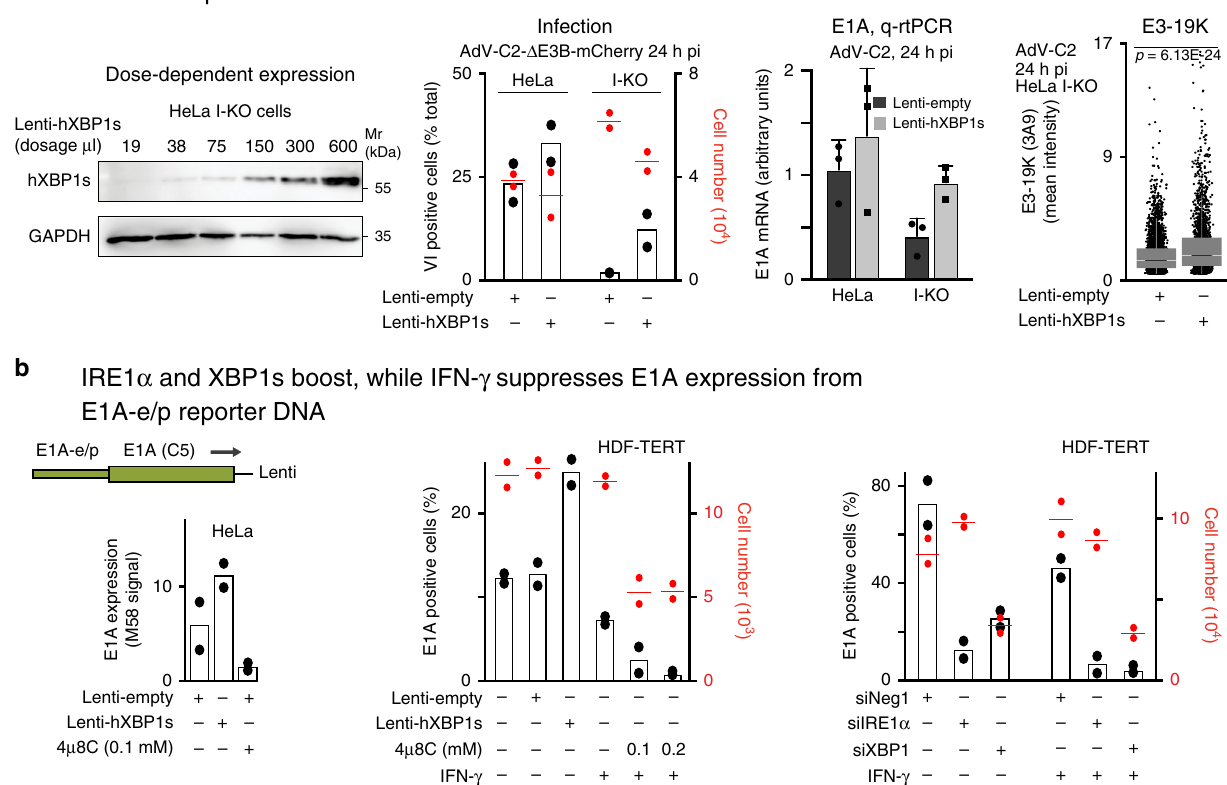
hXBP1s expression enhances E1A and E3-19K levels and infection